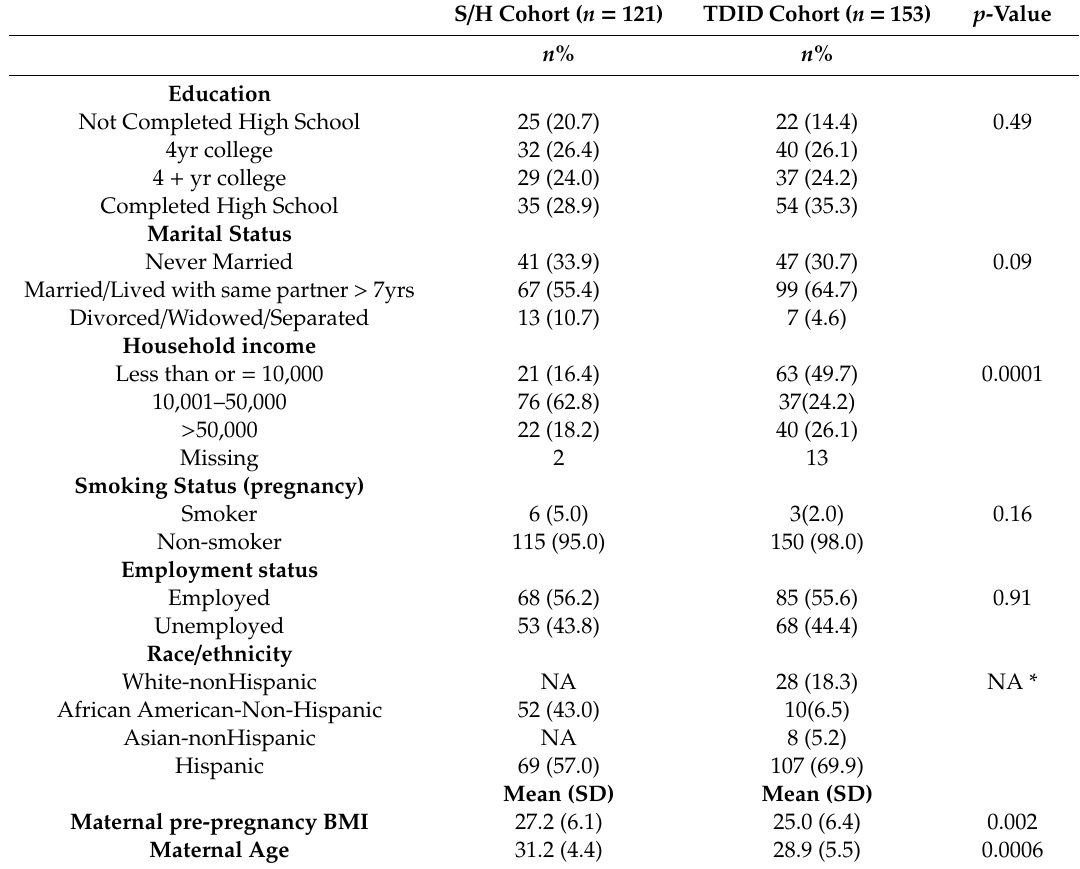
Table 1. Basic Demographic comparison between Thyroid Disruption and Infant Development (TDID) and Sibling / Hermanos (S / H)